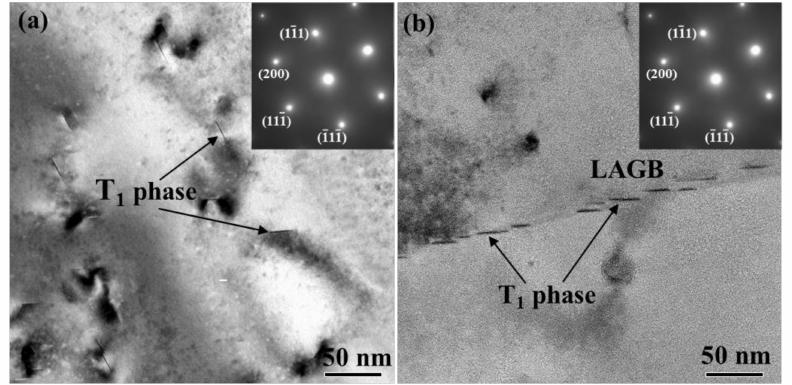
Figure 8. TEM images of the precipitates in 2A97 alloy that solution treated at 520 ◦ C for 1 h and cooled down to 420 ◦ C by FC: ( a ) sub-grains interior; ( b ) low angle grain